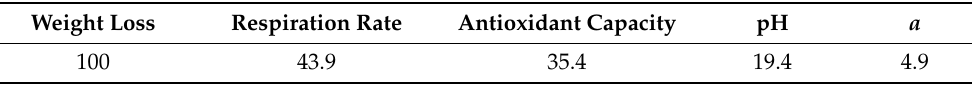
Table 7. The effect of variables on ethylene production prediction, using the Multivariate Adaptive Regression Splines (MARS) model in tomato fruit. Data are shown as